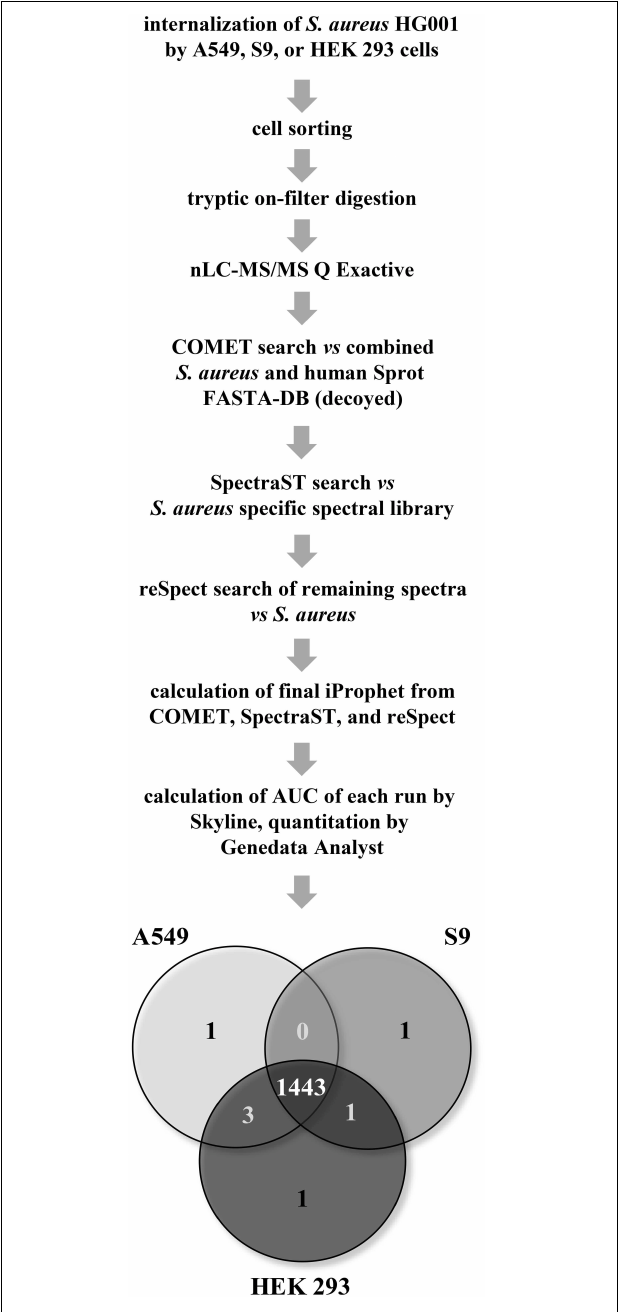
FIGURE 2 | Proteomics identification and quantitation workflow. Bacteria were sorted from host cell debris onto membrane filters by flow cytometry. Subsequently, bacterial proteins were digested on-filter using trypsin prior to nLC-MS/MS acquisition with a Q Exactive. Database analysis was performed in three steps: (i) COMET search against human and S. aureus HG001 Sprot database, (ii) SpectraST against a specific S. aureus HG001 spectral library, and (iii) reSpect search of non-matching spectra. Calculation of AUC of peptides and proteins exceeding an iProphet score of 0.8 was performed with Skyline and the Genedata Analyst. The Venn diagram represents all proteins which were detected in any of the three biological replicates for each host cell line.